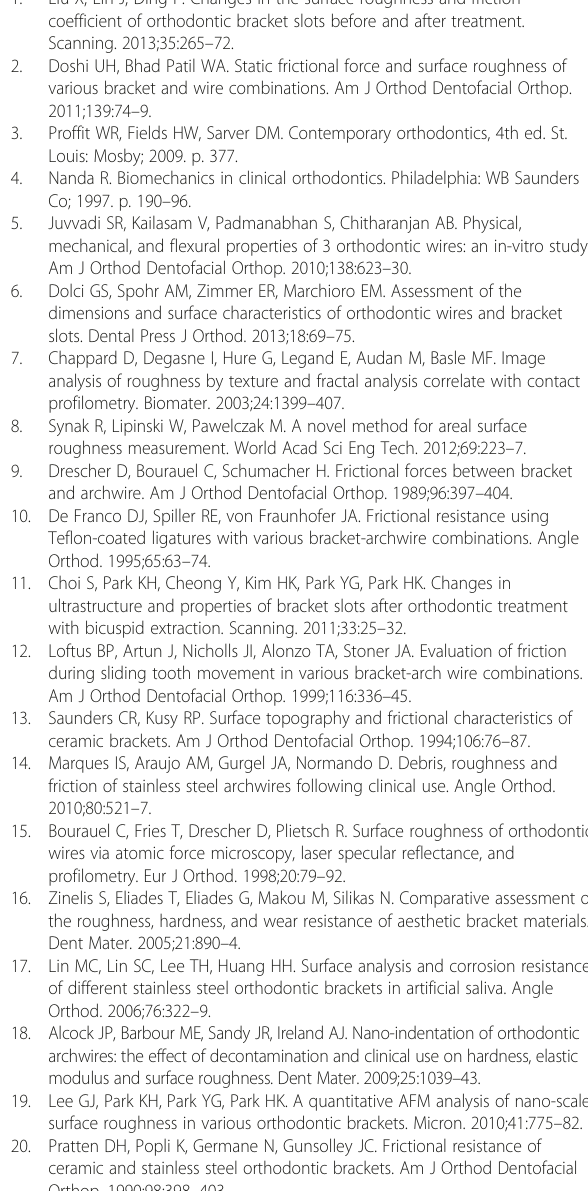
Group D — American